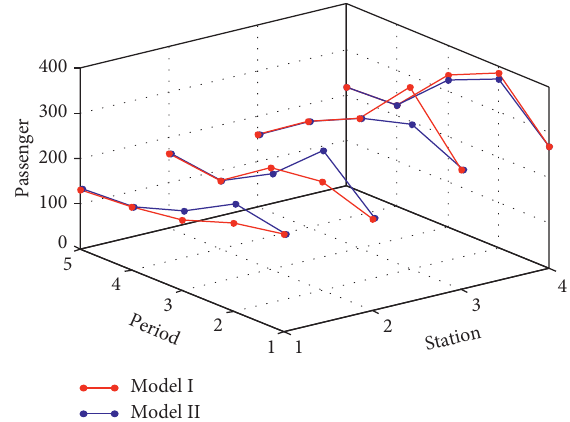
Figure 8: Comparison of waiting passengers at the entrance in two models.